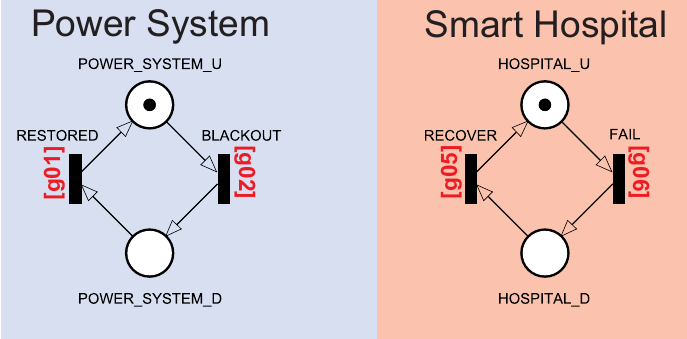
Figure 3. Power System and Smart Hospital building block control components. The Smart Hospital building block component represents the hospital system status. The hospital is active when all the Smart Hospital components are active. The hospital is deactivated when at least one of the components has tokens in the inactive state. The Smart Hospital is up when there is a token HOSPITAL_U . The Smart Hospital is not working when there is a token in HOSPITAL_D . The change between active and inactive states is caused by the transitions FAIL and RECOVER . Thus, the FAIL transition is activated when all energy sources are inactive, given by expression g05 = ((#CS_U>0) AND (#ES_U>0) AND (#RT_U>0) AND (GT_U>0) AND (F_D=0) AND (SV_U>0)) AND (POWER_SYSTEM_U>0). The RECOVER transition is activated when there is at least one energy source active, given by expression g06 = (#CS_U<1) OR (#ES_U<1) OR (#RT_D>0) OR (GT_D>0) OR (F_D>0) OR